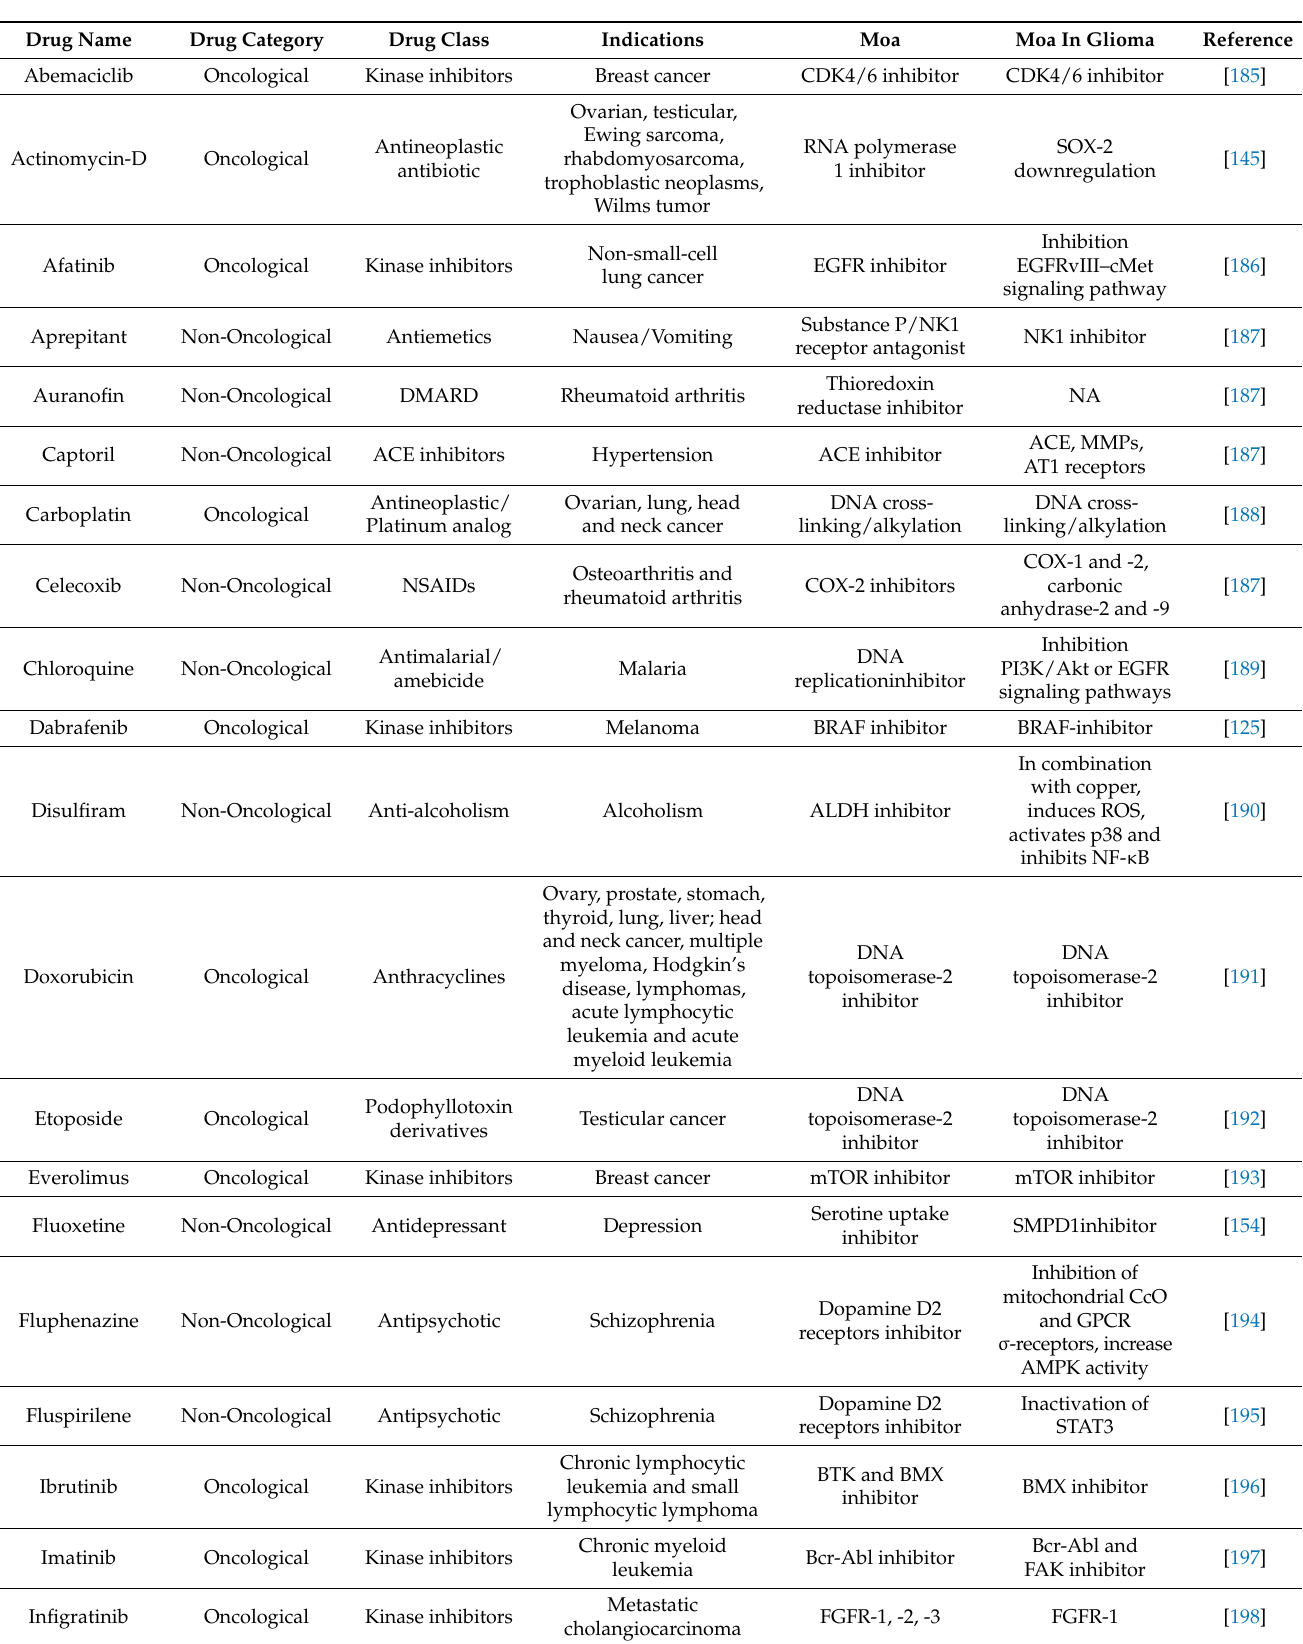
Table 1. Examples of oncological and non-oncological repurposed drugs under preclinical investiga- tion against